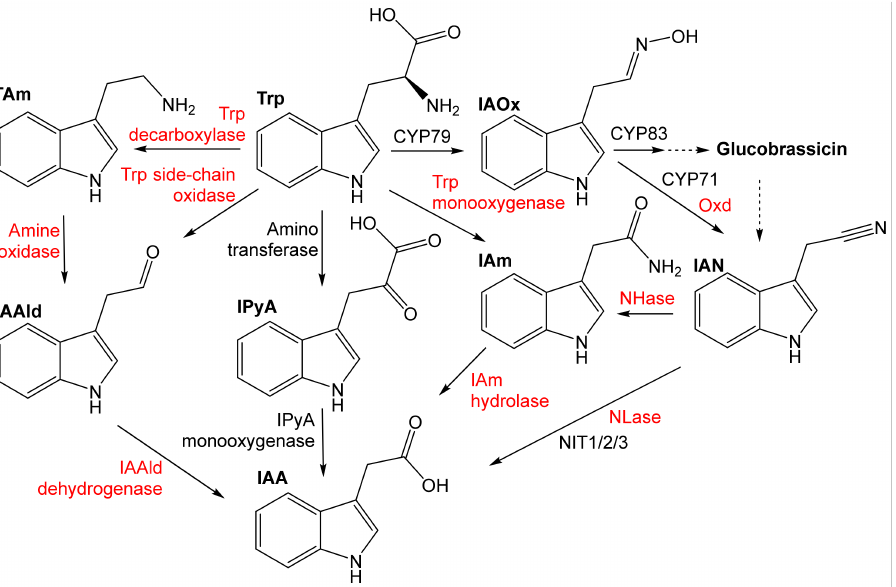
Figure 6. Trp-dependent biosynthesis of indole-3-acetic acid (IAA) in bacteria and plants (according to [1,3,10,57–59], modified). Enzymes typical of plants and bacteria are shown in black and red, respectively. IAA, indole-3-acetic acid; IAAld, indole-3-acetaldehyde; IAOx, indole-3-acetaldoxime; IAm, indole-3-acetamide; IAN, indole-3-acetonitrile; CYP, cytochrome P450 (CYP71, CYP79, and CYP83 family); IPyA, indole-3-pyruvate; NIT1/2/3, plant nitrilases of NIT1, NIT2, and NIT3 type; NLase,